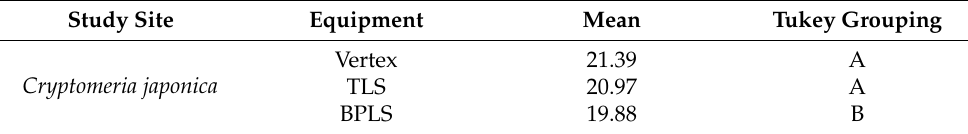
Table 9. Post-hoc results of height for Cryptomeria japonica .